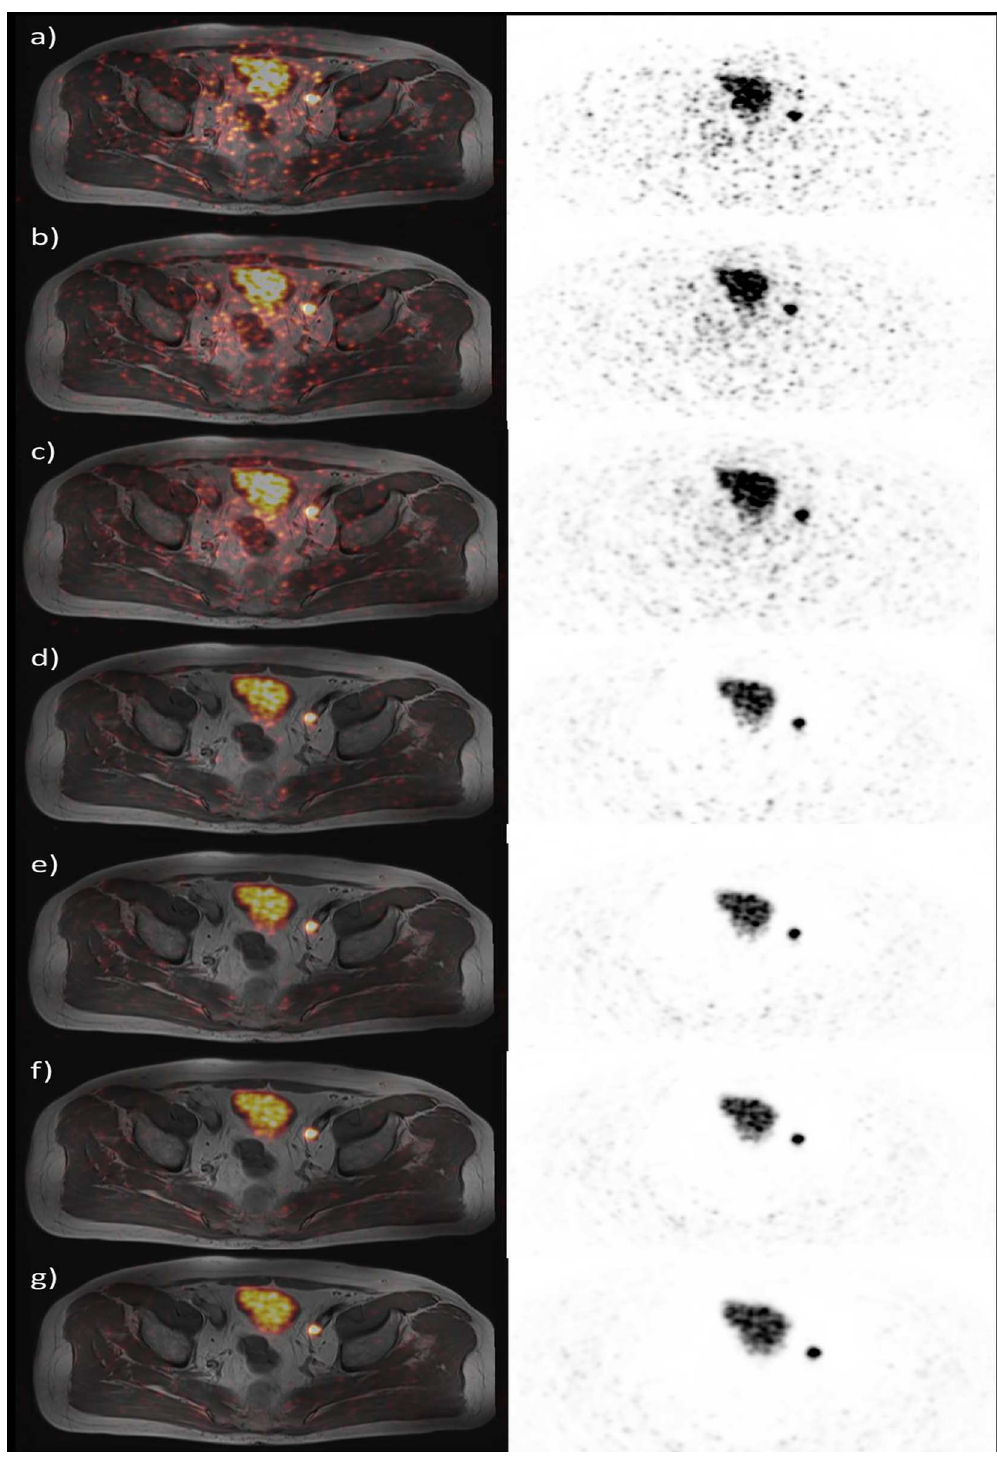
Fig 3. Image quality of 68 Ga-HBED-CC-PSMA PET/MRI of a patient with recurrent PCa in an ilical lymph node. Images were acquiredat 3 h p.i.. Left panel: PET/MR fusion image, right panel: PET image of the PET/MR hybrid imagingsystem. Acquisition times were a) 1 min, b) 2 min, c) 3 min, d) 4 min, e) 6 min, f) 8 min, and g) 10 min. PET image quality rises with increasingacquisitiontimes and reaches a plateauat an acquisition time of 4 min. The halo artifact first occurs at image acquisition times of 4